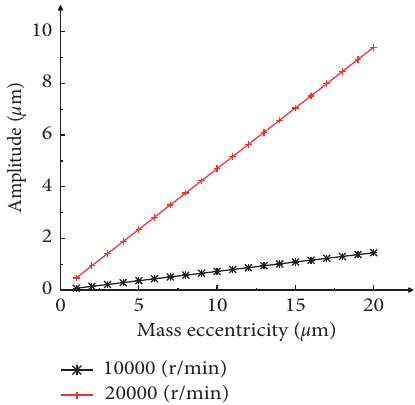
Figure 10: Effect of mass eccentricity on vibration without static eccentricity.